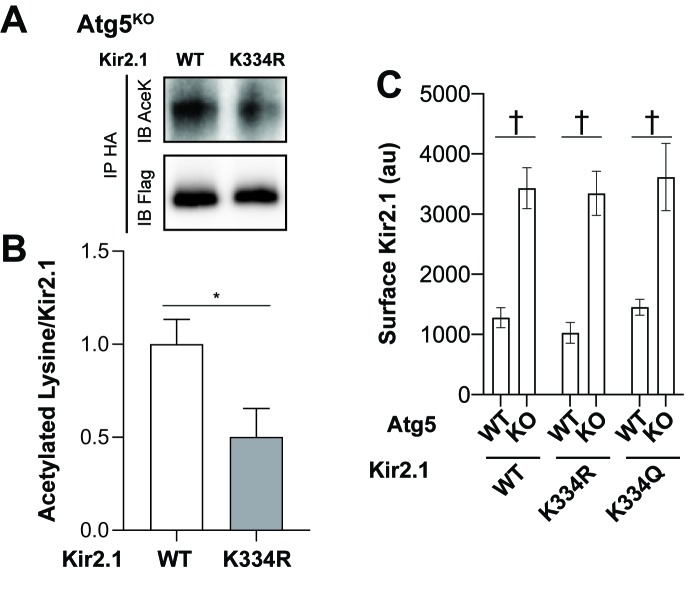
Reduced acetylation of Kir2.1 K334R in Atg5KO MEFs but acetylation status at K334 does not affect surface residence of Kir2.1.(A) Representative western blots of immunoprecipitated WT Kir2.1extHA-Flag-SNAP or Kir2.1extHA-Flag-SNAP K334R. Immunoblots for acetylated lysines (AceK) or Flag. (B) Quantification of acetylated lysine signal normalized to WT or K334R Kir2.1extHA-Flag-SNAP in immunoprecipiates from Atg5KO MEFs shows a reduction in total Kir2.1 acetylation when K334 is mutated to arginine. Data analyzed with two-tailed, unpaired t test. t10 = 2.452; p = 0.0341. (C) Surface staining for WT Kir2.1, Kir2.1 K334R, and Kir2.1 K334Q in Atg5WT or Atg5KO MEFs reveals that mutations at K334 does not affect surface localization of Kir2.1 in either MEF cell line. Data analyzed with two-way ANOVA. Cell genotype x Channel genotype: F(2,142)=0.04505, p = 0.9560; Cell genotype: F(1,142)=75.66, p<0.0001; Channel Genotype: F(2,142)=0.6539, p = 0.5216. *p<0.05, † p<0.0001.